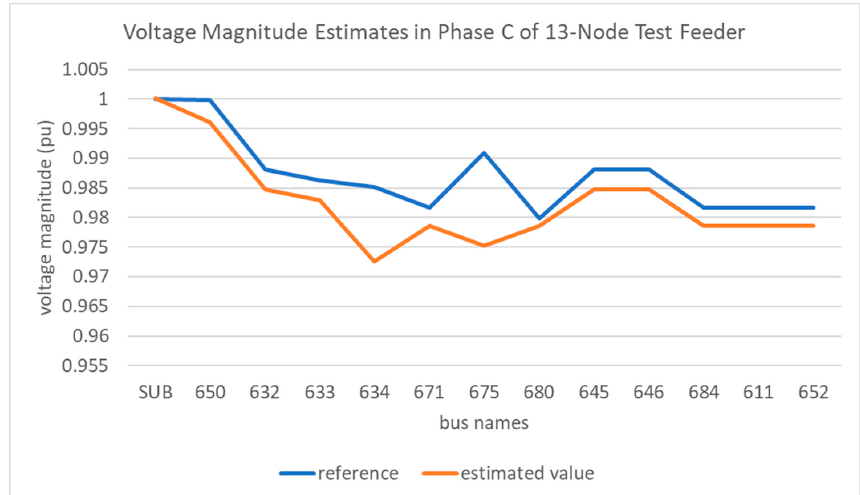
Figure 6. 13-bus feeder’s voltage magnitude estimates in phase C.